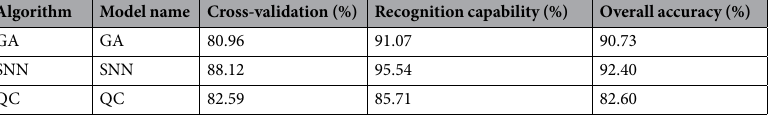
Table 2. Cross-validation and recognition capability of the three algorithms used to classify different PMIs in human liver